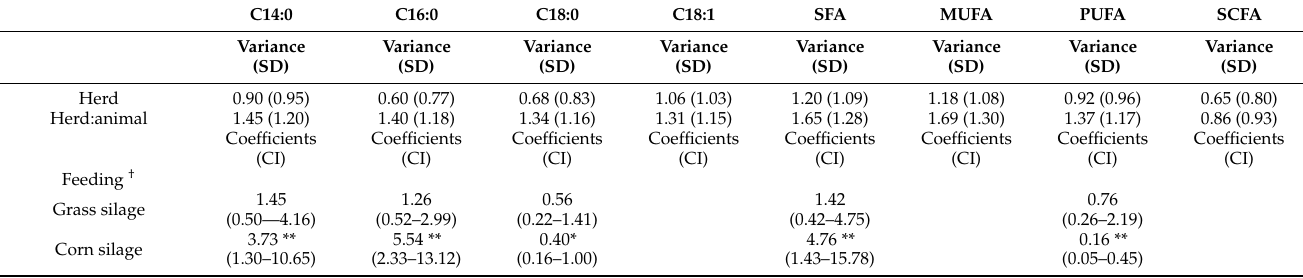
Table 4. Results of mixed effects ordinal regression models for the effect of type of ration, calving number, season, lactation phase and energy corrected milk (explanatory variables) on mean amounts of myristic (C14:0), palmitic (C16:0), stearic (C18:0), oleic (C18:1), saturated (SFA), monounsaturated (MUFA), polyunsaturated (PUFA) and short chain fatty acid (SCFA) (g/100 g fatty acids) (dependent variables) in milk samples from dairy cows in Galicia (NW Spain). The regression coefficients— provided with their 95% confident intervals (CI)—indicate the likelihood of being in a higher